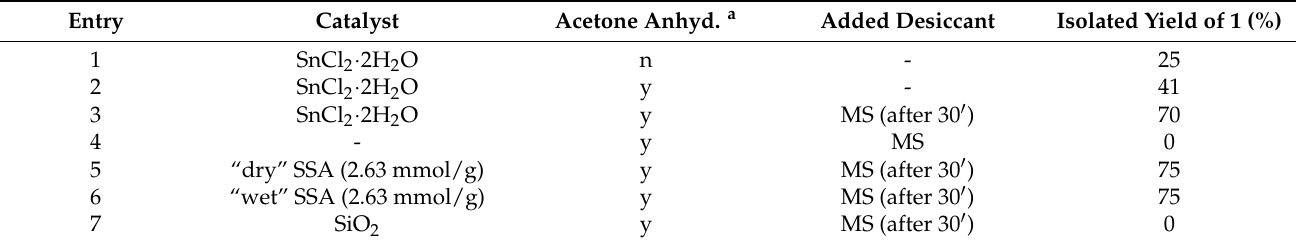
Table 1. Preliminary catalyst